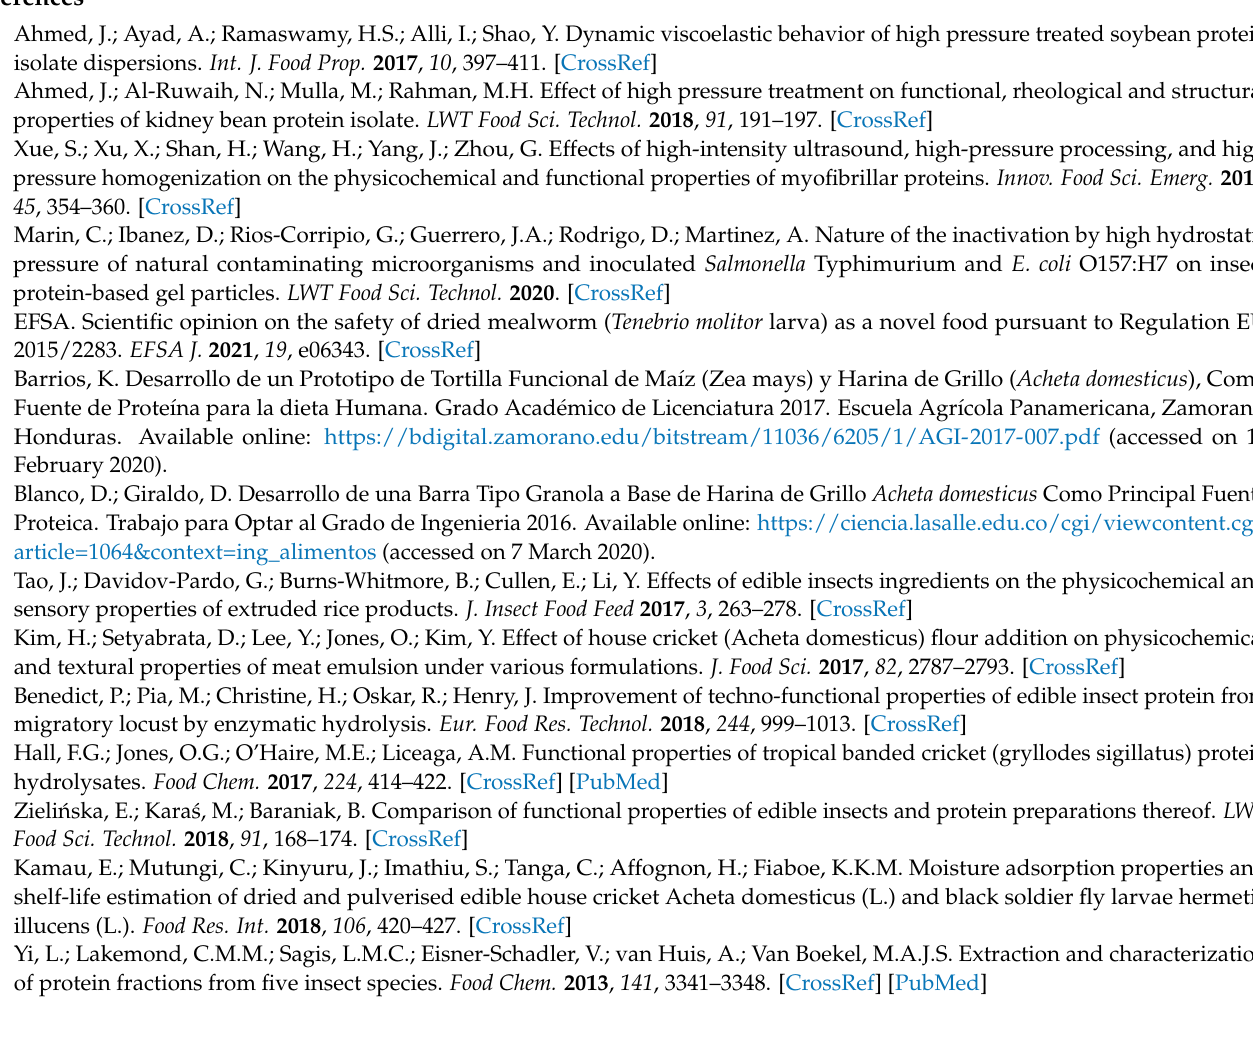
after incubation with enzymes, Table S1: Hardness histogram pellet, Table S2: Hardness histogram soluble, Table S3: Syneresis histogram pellet, Table S4: Syneresis histogram soluble, Table S5: Figure of pH evolution pellet, acid and alkaline extraction, Table S6: Figure of pH evolution soluble, acid and alkaline extraction, Table S7: Figure of pH evolution